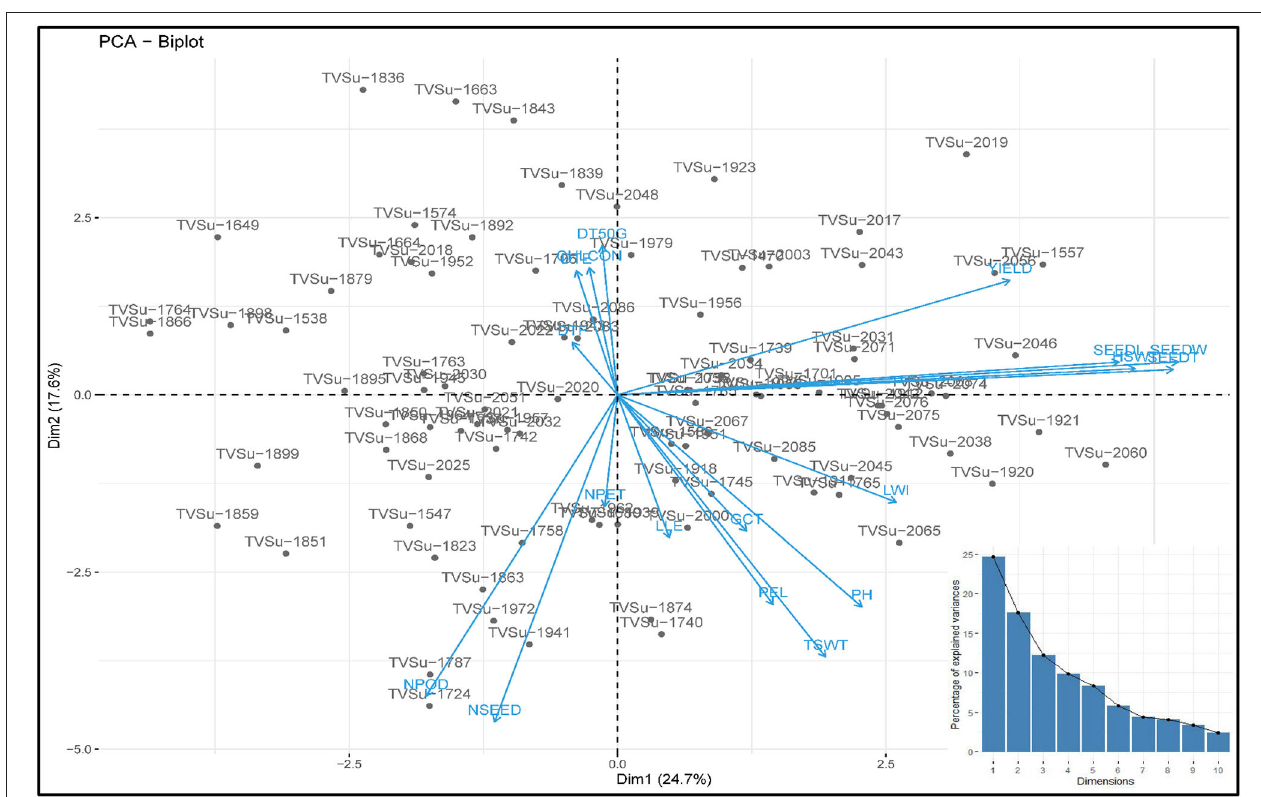
FIGURE 2 | PC 1 and PC 2 biplot using quantitative trait scores of the Bambara groundnut (BGN) accessions. Each accession is represented according to its origin. Inset is the scree plot showing the explained variances.